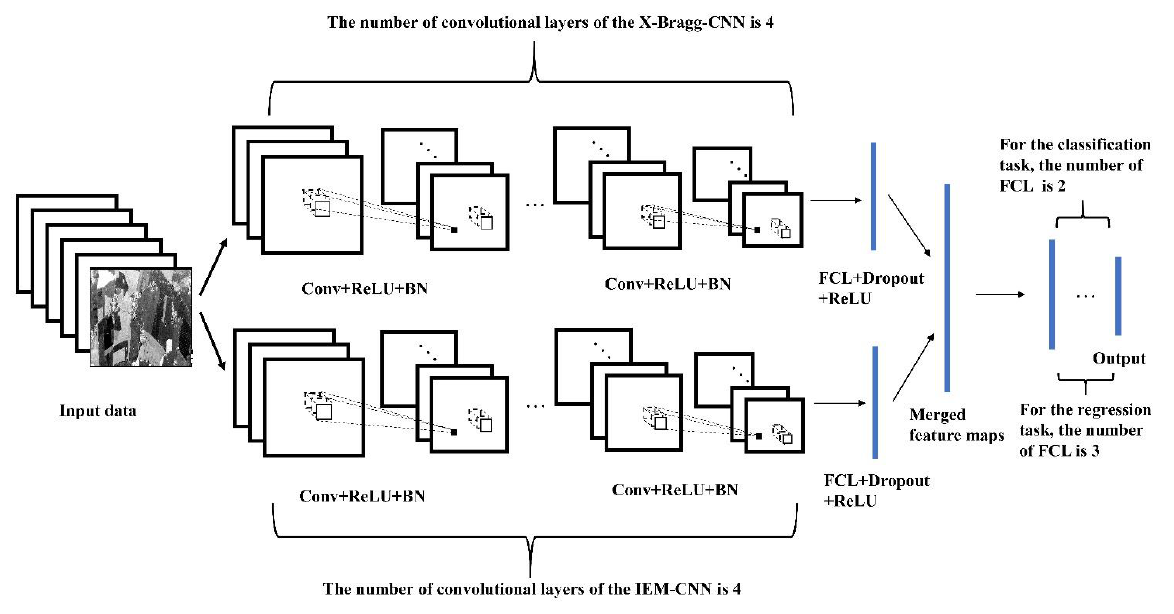
Figure 2. Overview of the dual-channel CNN architecture. Table 2. Configuration of the classification CNN. The input data is an 11 × 11 × 6 multi-dimensional matrix, which indicates that the local patch size is 11 × 11 and the number of input feature channels is 6. In the convolu- tional layer, the input data I and a set of preset filters W are convolved and then added to the offset b . Finally, the nonlinear activation function, as shown in Equation (28), is used to obtain the local feature F.